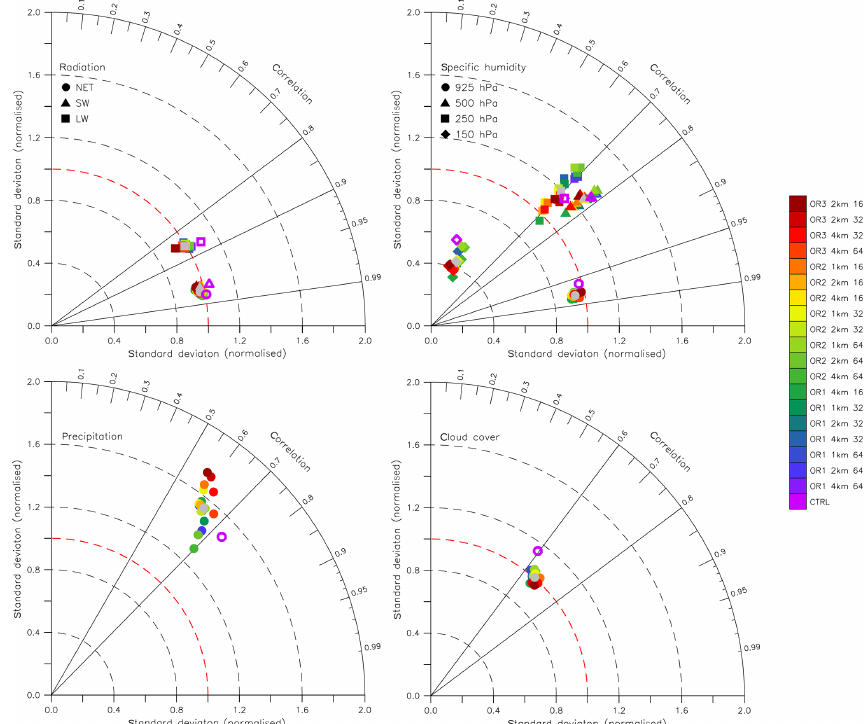
Figure 2. Taylor diagrams summarising radiative fluxes at TOA, specific humidity on selected pressure levels, precipitation and total cloud cover. Individual simulations are colour-coded, whereas grey markers represent the overall SP-EMAC ensemble. The control simulation is marked with open purple–white symbols. Observational data for radiation at TOA, total cloud cover and precipitation are the same as indicated in Table 2. For specific humidity, NCEP/DOE2 reanalysis data are used from January 1979 to December 2010 and evaluated only over continental